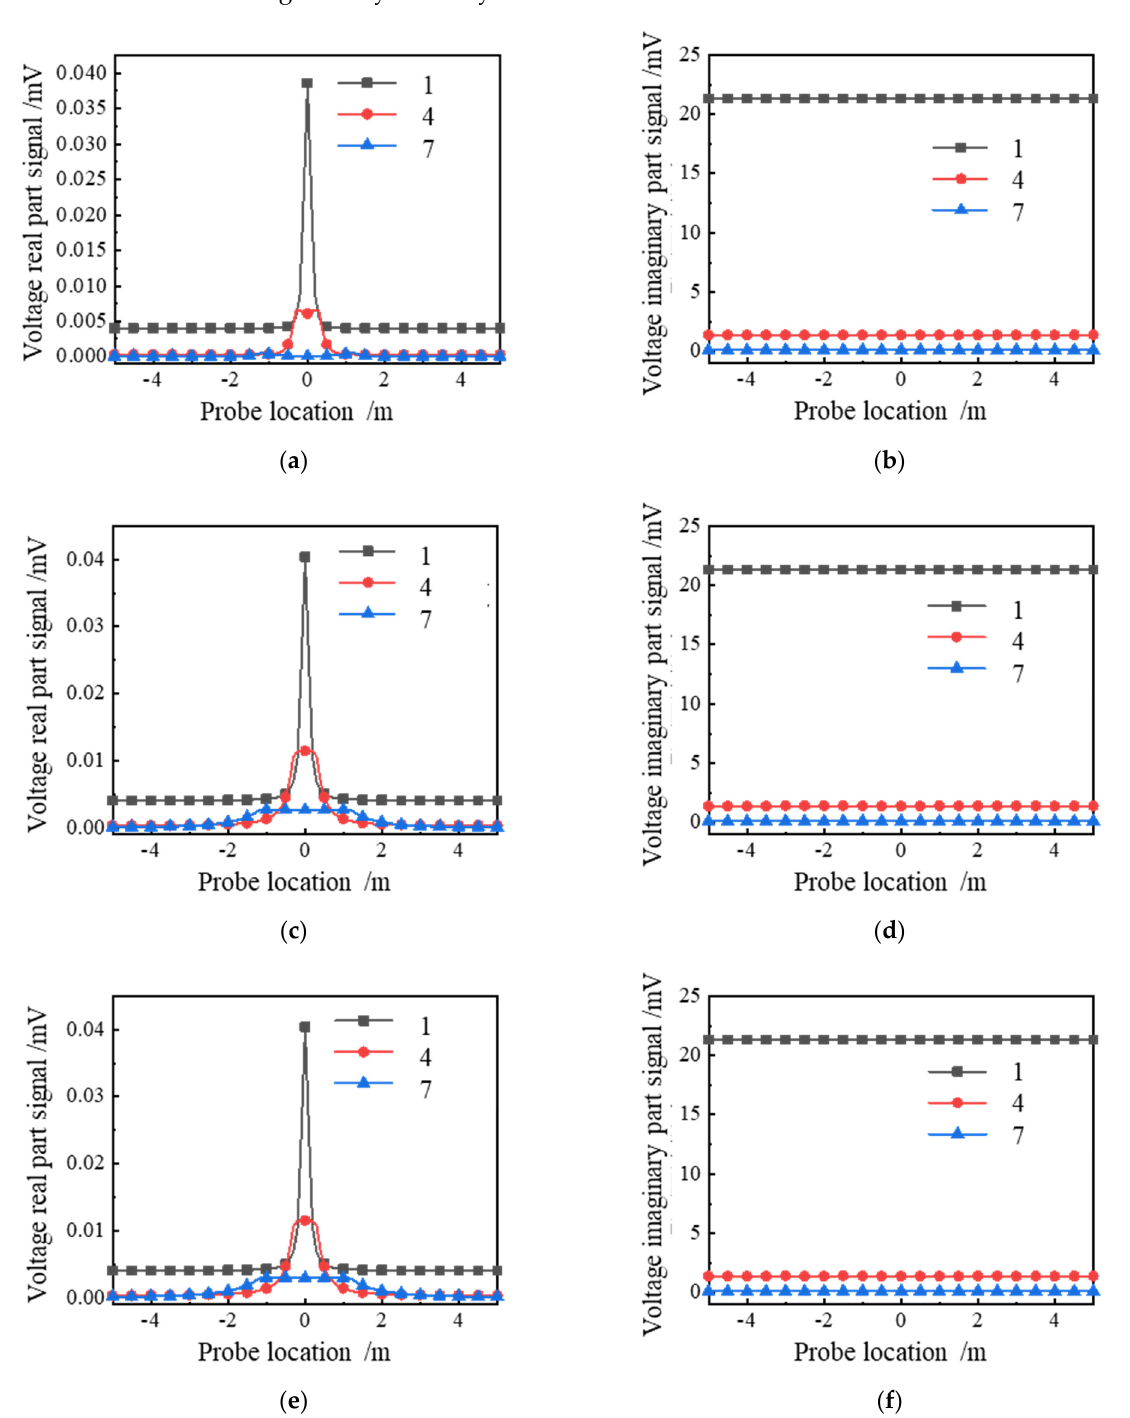
Figure 10. Electromagnetic signal response curves of circular fractures with different sizes: ( a ) real part signal of a 1 m diameter circular fracture; ( b ) imaginary part signal of a 1 m diameter circular fracture; ( c ) real part signal of a 10 m diameter circular fracture; ( d ) imaginary part signal of a 10 m diameter circular fracture; ( e ) real part signal of a 100 m diameter circular fracture; ( f ) imaginary part signal of a 100 m diameter circular fracture.